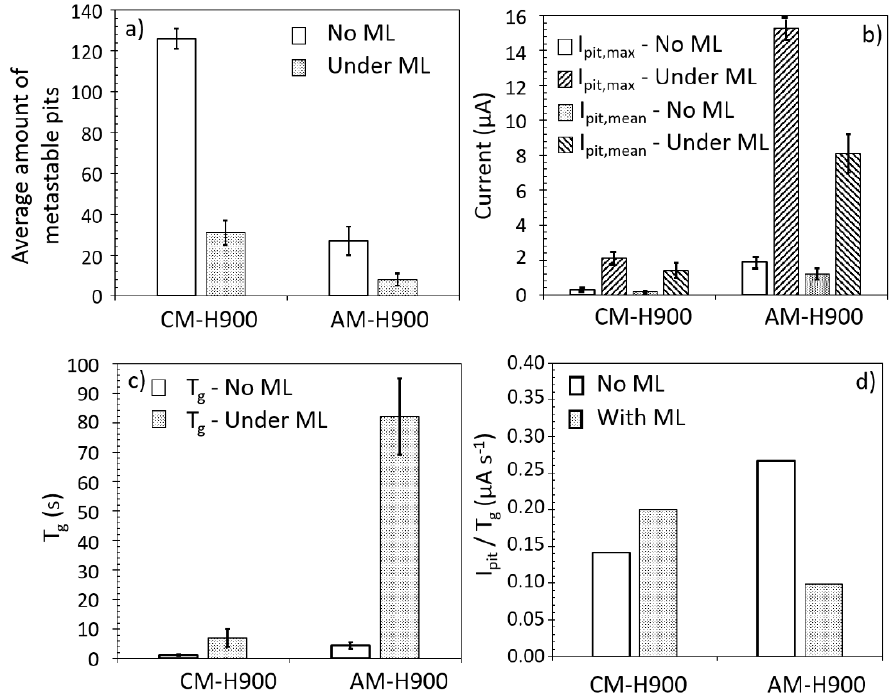
Figure 11. Results of the statistical analysis of the current transients observed for the samples exposed to 0.5 M NaCl solution, without mechanical loading (ML), and with mechanical loading (EAC tests with an imposed strain corresponding to an initial stress of 80% of the YS 0 . 2 value). The results are given for the AM and CM samples of MSS: ( a ) Average amount of metastable pits; ( b ) I pit (max and mean values); ( c ) T g ; ( d ) I pit /T g